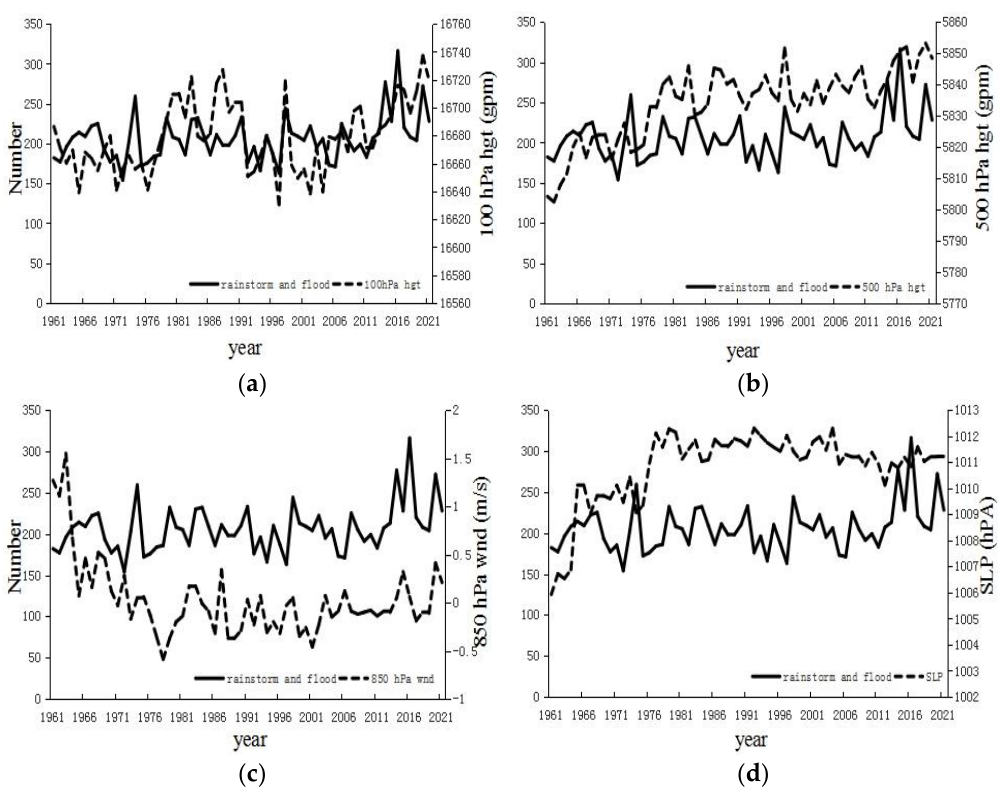
Figure 6. Observed cumulative rainstorm and flood values (solid line), 100 hPa height ( a ) and 500 hPa height ( b ), 850 hPa wind speed ( c ) and sea level pressure field ( d ), in the summer half-year of 1961–2021 (dashed lines).